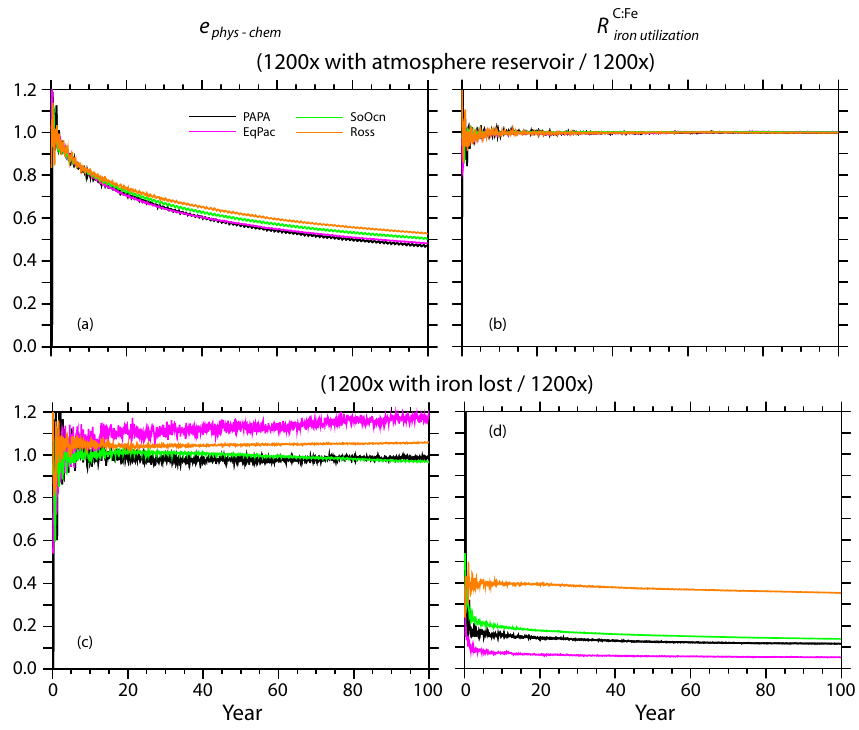
Fig. 11. Sensitivity studies of factors contributing to the efficiency of the 1200x simulations. Panels (a) and (b) examine the sensitivity to the inclusion of an atmospheric reservoir, and Panels (c) and (d) examine the sensitivity to the retention of iron, all plotted as a function of time from 0 to 100 years. The first row shows the uptake efficiency e phys − chem and the overall C:Fe iron utilization ratio, R C : Fe the simulation with a variable atmosphere divided by the corresponding quantity in the standard 1200x simulation. The second row shows e phys − chem and R C : Fe for the simulation with no iron remineralization divided by the corresponding quantity in the standard 1200x ironaddition